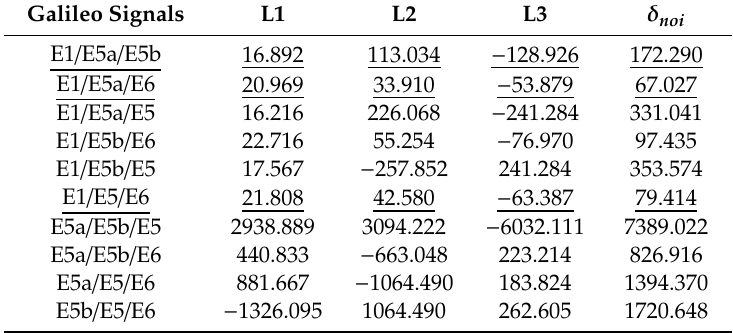
Table 1. Scaling coe ffi cients of L1, L2, and L3 for ionosphere-free wide-lane observables and the phase noise amplification factors of di ff erent Galileo triple-frequency combinations relative to the raw phase observations.